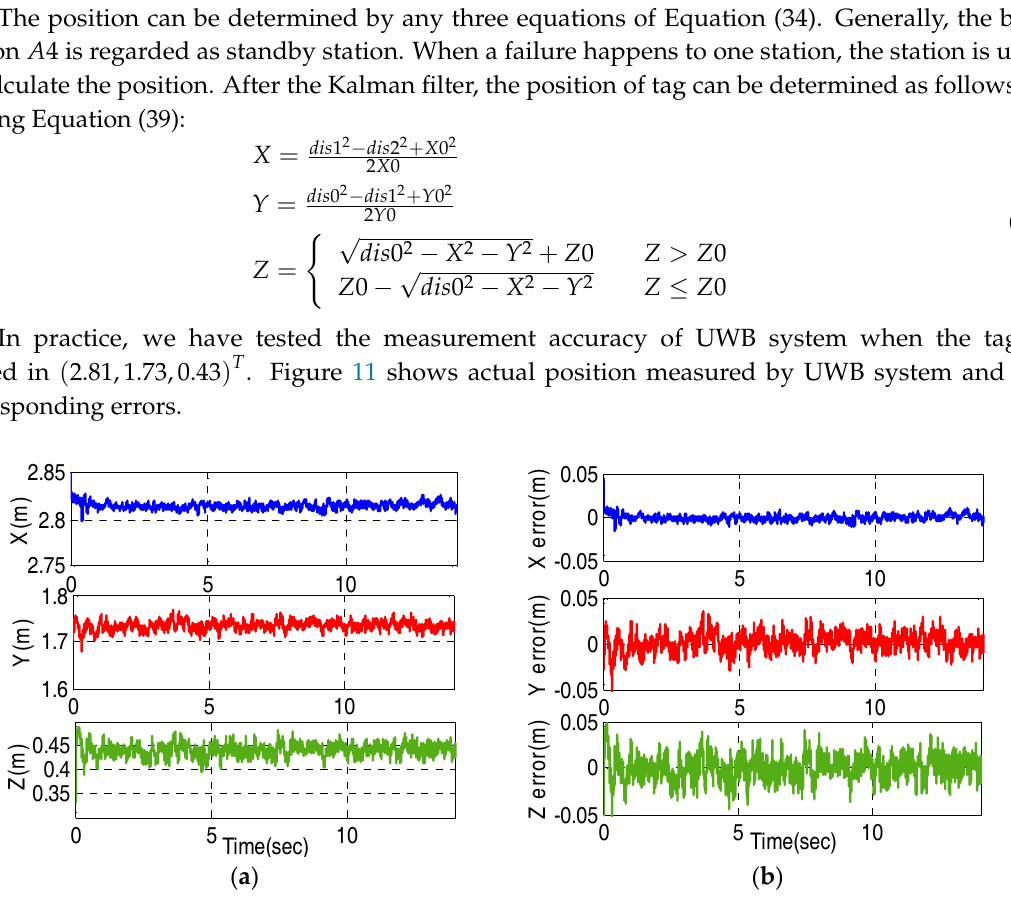
Figure 11. The measured position by UWB system and the corresponding errors ( a ) The measured position by UWB system; ( b ) The corresponding position errors.